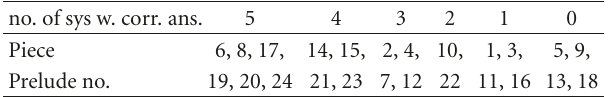
Figure 10: Results of five systems on Chopin’s 24 Preludes T: tonic, D: dominant, S: subdominant, R: relative, P: parallel. Table 3: Summary of the results of five systems categorizing the pieces by the number of the correct